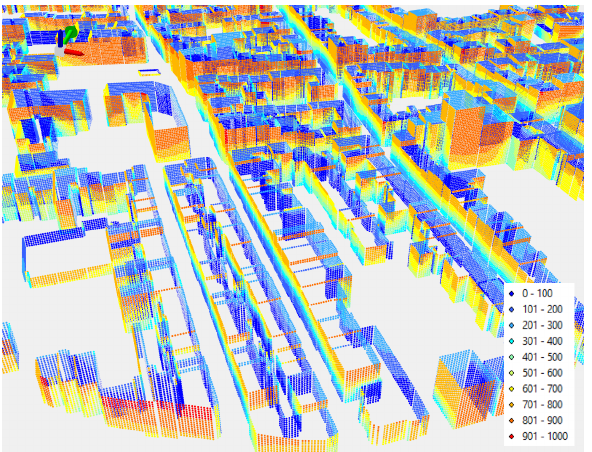
Figure 5. Global irradiation per hyper-point [kWh/a] (clipping, south-west city area)